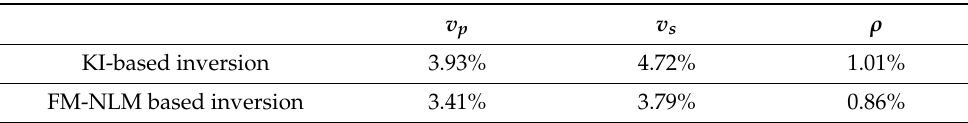
( d ) Figure 11. Prestack seismic inversion results of P-wave velocity at CDP 10 by ( a ) KI model and ( b ) FM-NLM, and inversion results at CDP 295 by ( c ) KI model and ( d ) FM-NLM. 3.2 Field Data Example We also test the proposed method on a field data set. There are 401 CDPs and 401 sampling points at each CDP. The observed angle gathers of 0°, 15°, and 30° are shown in Figure 12a–c. The poststack seismic record is displayed in Figure 12d. There are three wells on this seismic profile, which are located at CDP 36, CDP 161, and CDP 304. 2000